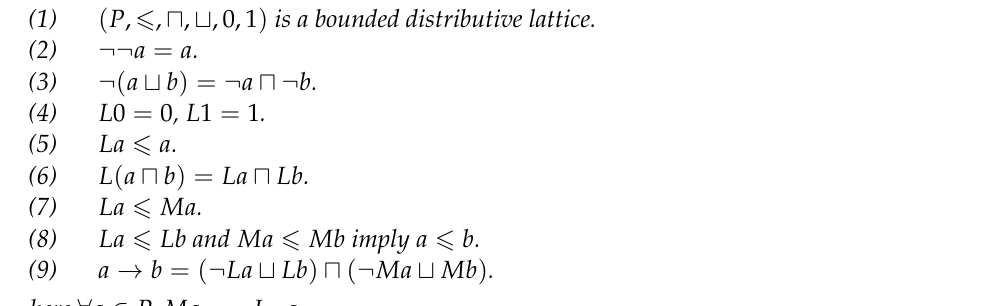
Table 2. The operations of ¬ , L and M in { 0, 1